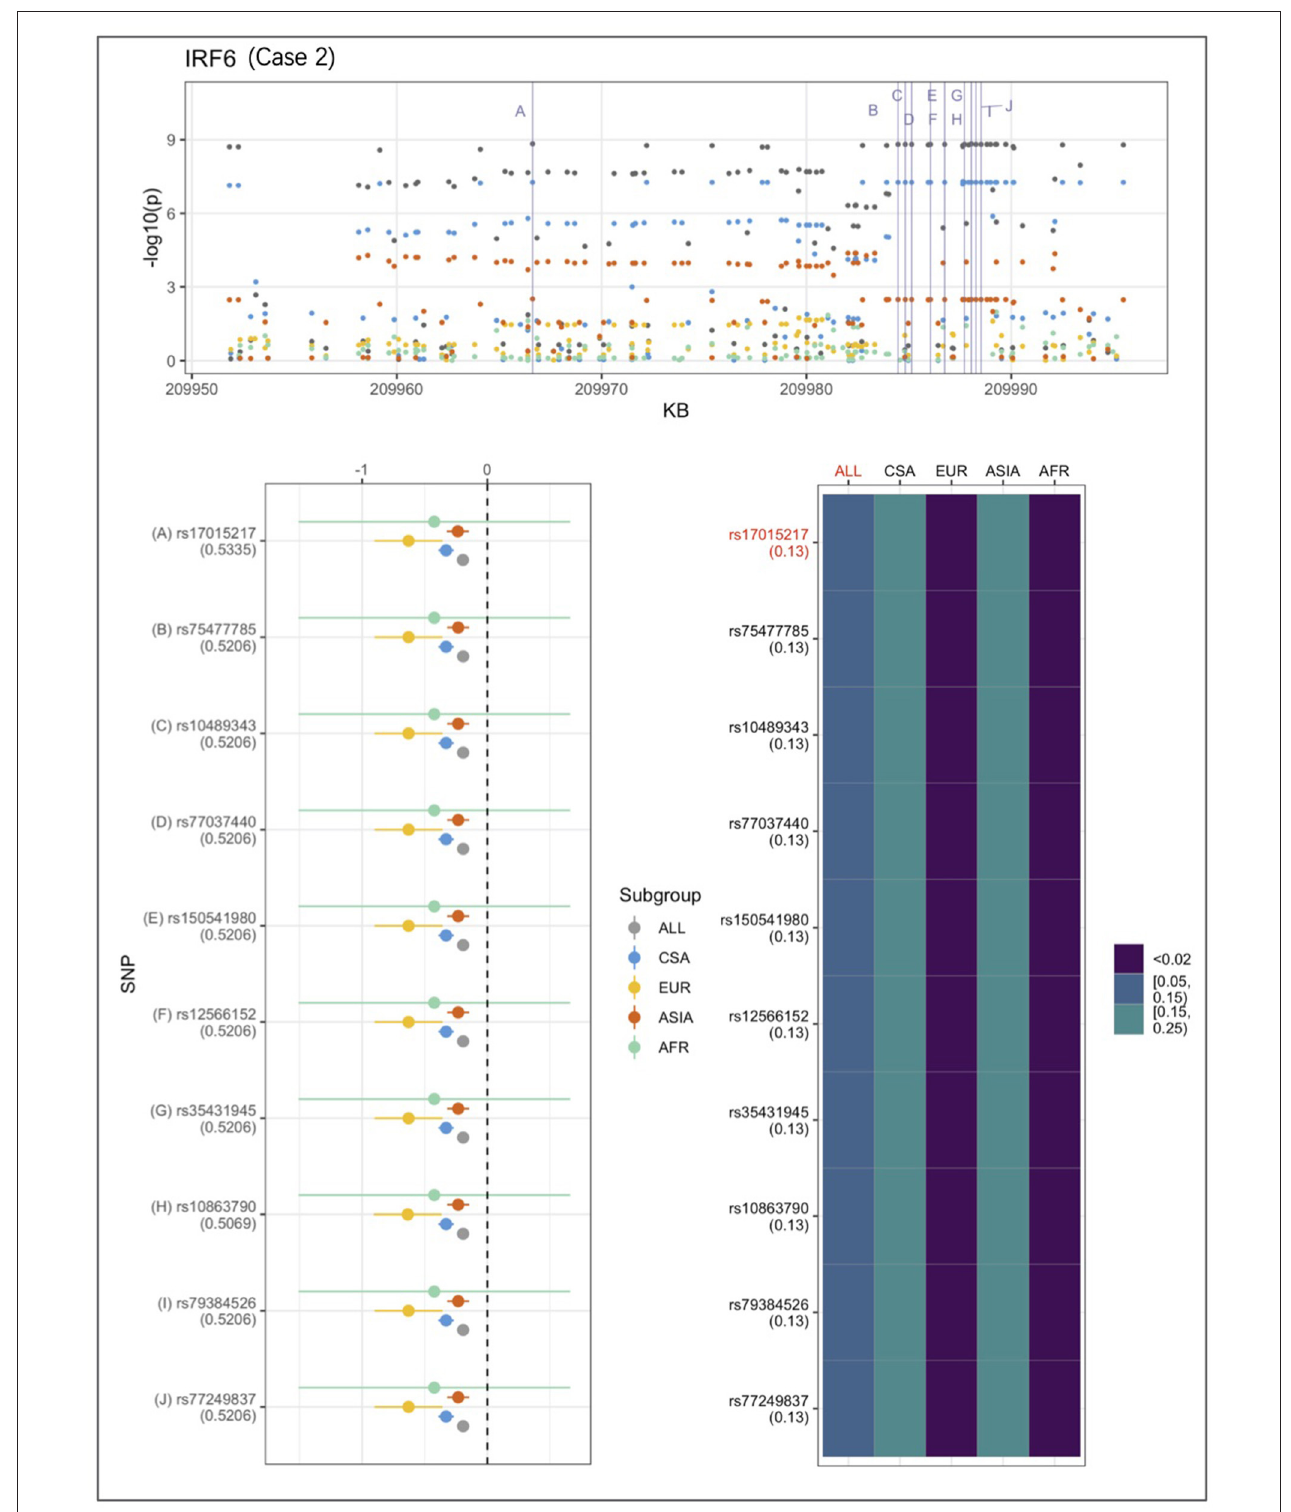
FIGURE 3 | Association peak in 1q32.2 ( IRF6 ) consistent with category 2. SNPs are ordered by base-pair position; Q-statistic p -value noted under each SNP in forest plot; lead variant and sample with highest p -value shown in red in heatmap and F ST values noted under each SNP. The top 10 associated variants fall below our MAF filter in the EUR and ASIA